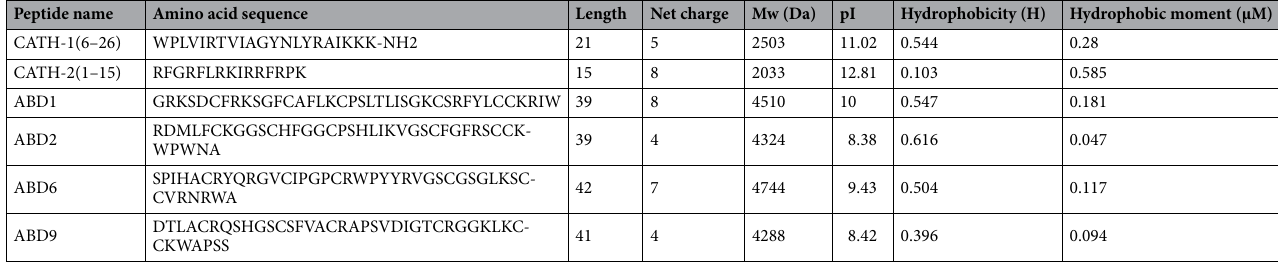
Table 1. Physiochemical properties and predicted secondary structures of six avian peptides used in this study. α-helical structures, random-coil, and extended-strand are indicated as letters h, c, and e,